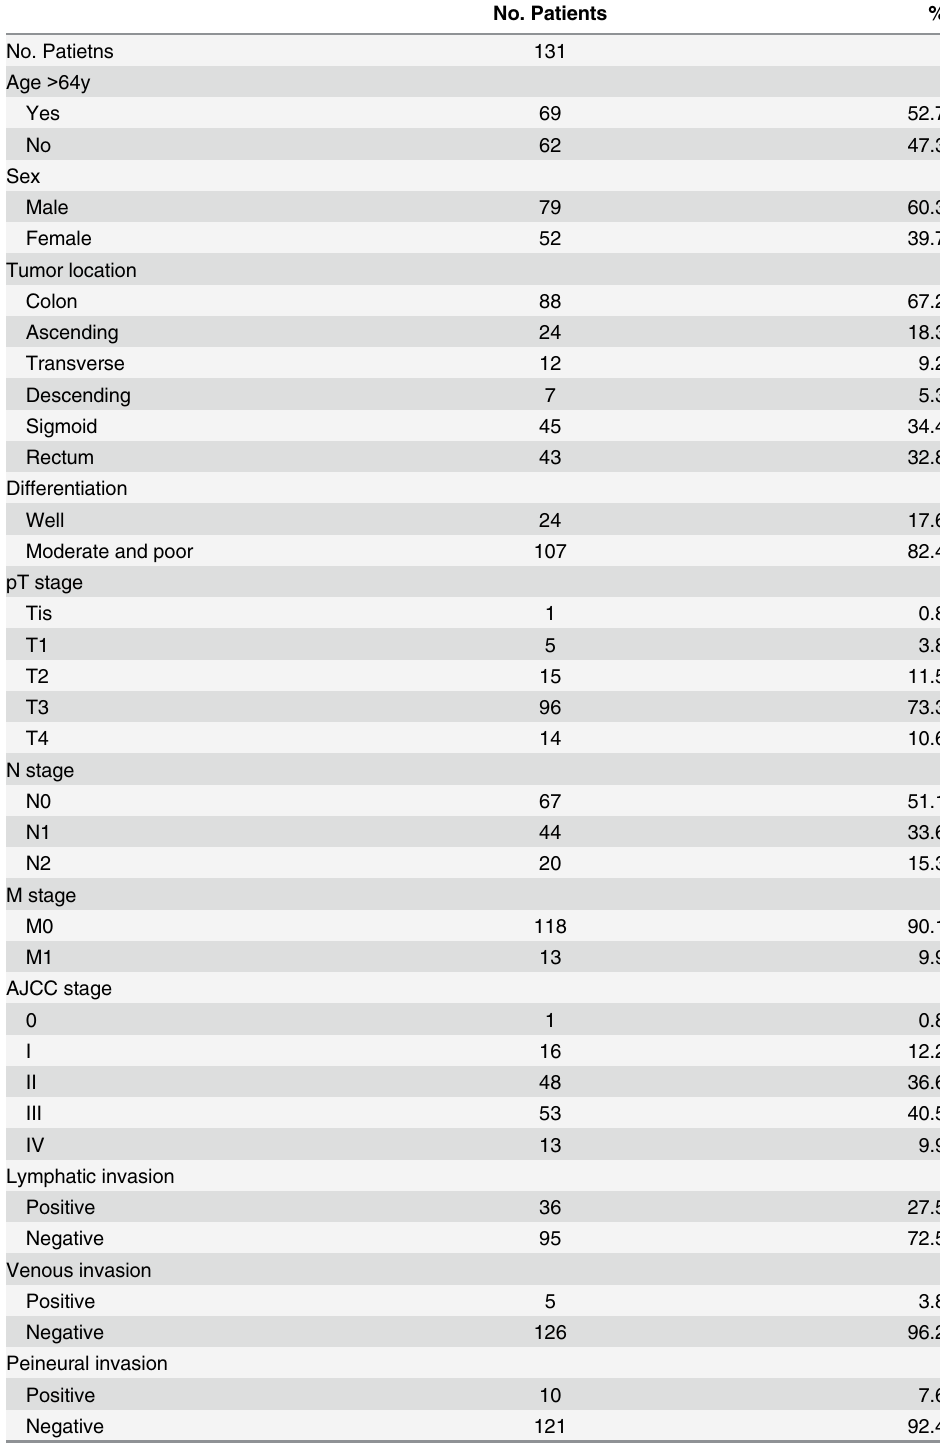
Table 1. Overall patient